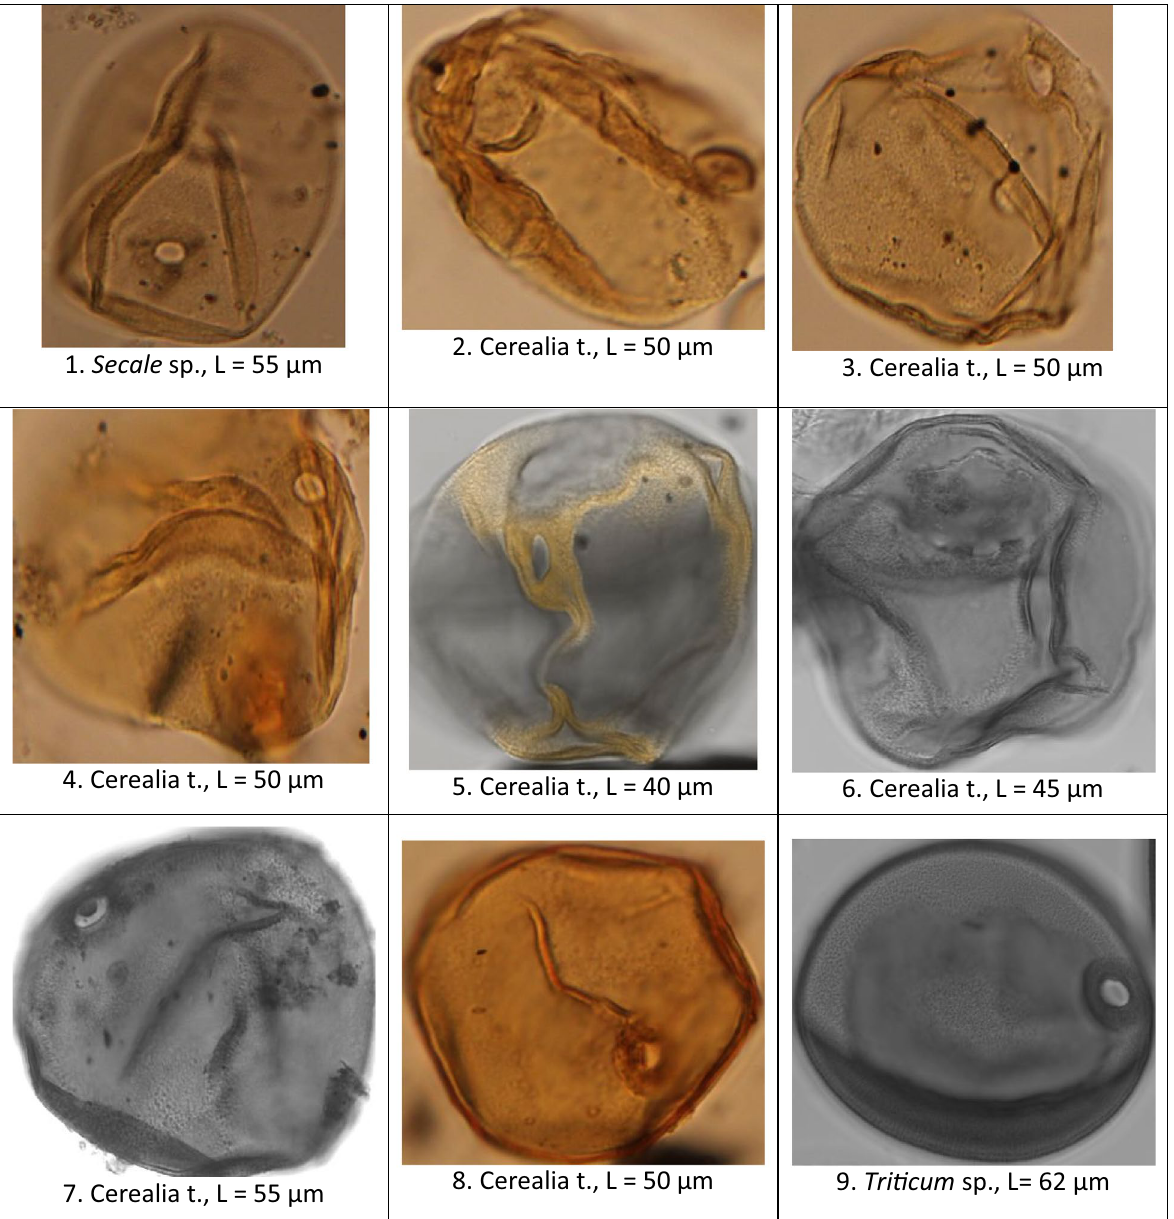
Figure 5. Pollen grain of Cerealia and Triticum sp. from Acıgöl (ACI), core 3 (photos 1–7), the Roman site of La Verrerie, Arles, France (photo 8) and Gardouch, France, current wheat field (photo 9). Photographies with a photonic (photo 1 – 4 and 8) and a confocal microscope (photos 5-7 and 9). 1) sample ACI 239 m, age: 0.871 Ma. 2) sample ACI 435.50 m, age: 1.709 Ma. 3) sample ACI 532.44 m, age: 2.122 Ma. 4) sample ACI 509.50 m, age: 2.026 Ma. 5) sample ACI 552.57 m, age 2.206. 6) sample ACI 552.57 m, age: 2.206 Ma. 7) sample ACI 429.50 m, age: 1.681 Ma. 8) sample La Verrerie 1455, age: 50-70 BC (Roman). 9) current pollen of Triticum sp., age: 2000 AD. L: maximal length